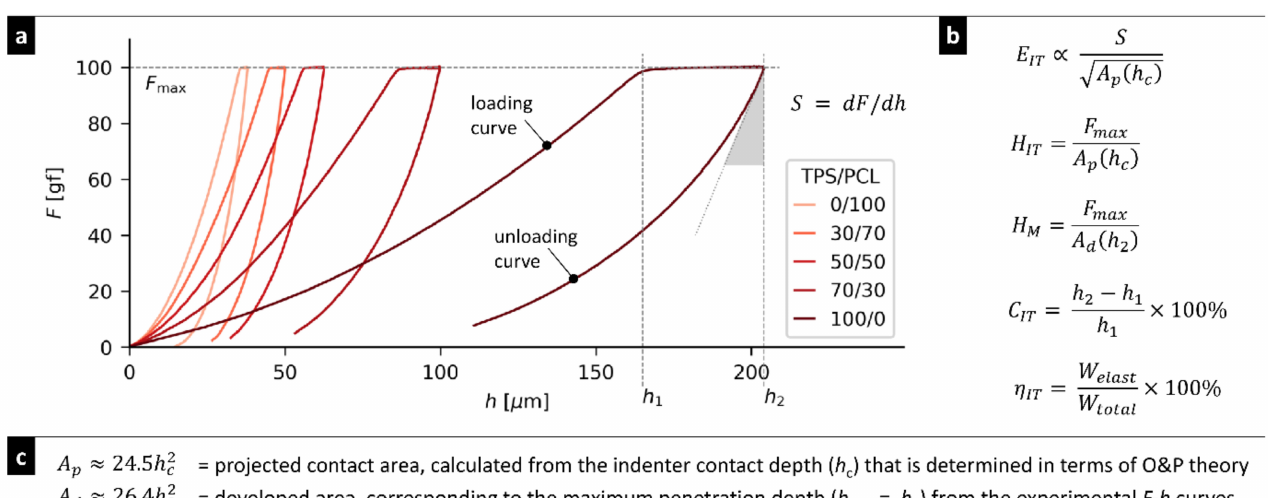
Figure 1. Principle of MHI measurements, which were employed in this work: ( a ) Micromechanical properties were deduced from the experimental F – h curves (where F is the indenter loading force and h is the indenter penetration depth) by means of ( b ) formulas and ( c ) relations containing experimental parameters, such as maximum loading force ( F max ), slope at the beginning of the unloading curve ( S ), penetration depths at the beginning and end of the maximal load ( h 1 and h 2 ), and areas under loading and unloading curve ( W elast and W total ). Additional parameter, contact depth ( h c ), was calculated in terms of the Oliver and Pharr theory and employed in the calculation of E IT and H IT , as described in our previous work [41,42]. The figure shows real, representative F – h curves of TPS/PCL systems, which the illustrate substantial changes of all studied properties as a function of